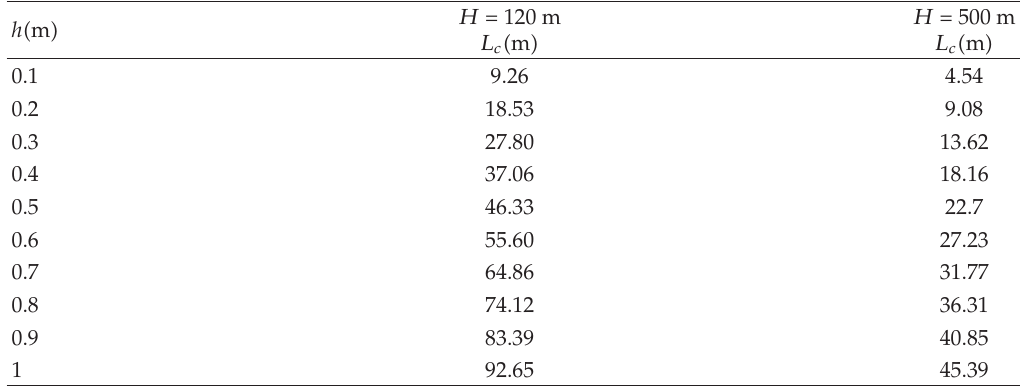
Table 1: Critical length L c